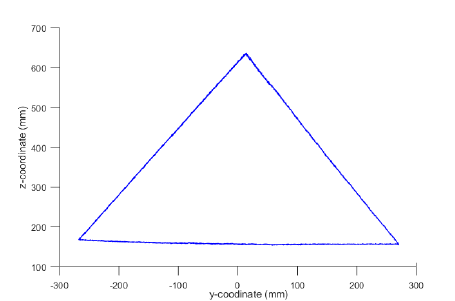
Figure 8. Figure performed by the robot.